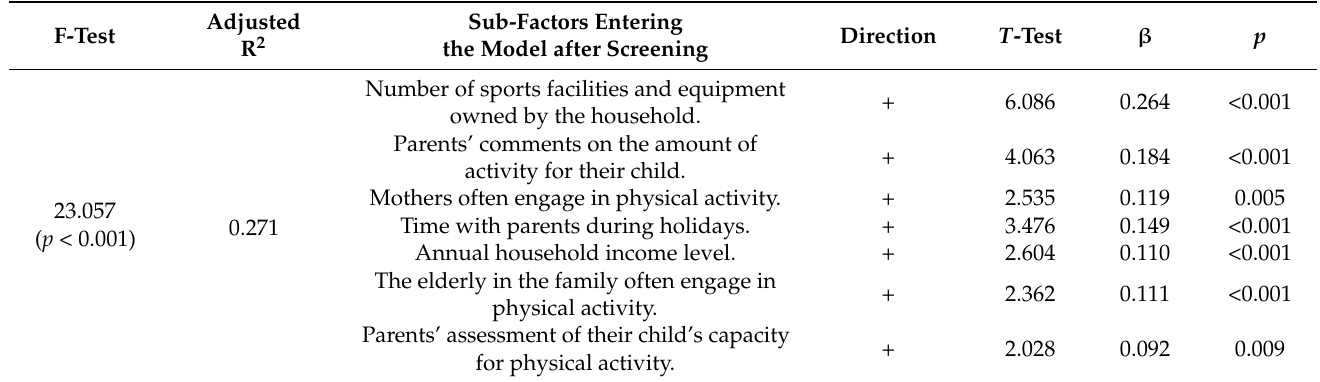
Table 5. Table of multiple regression models for the effect of home environment subfactors